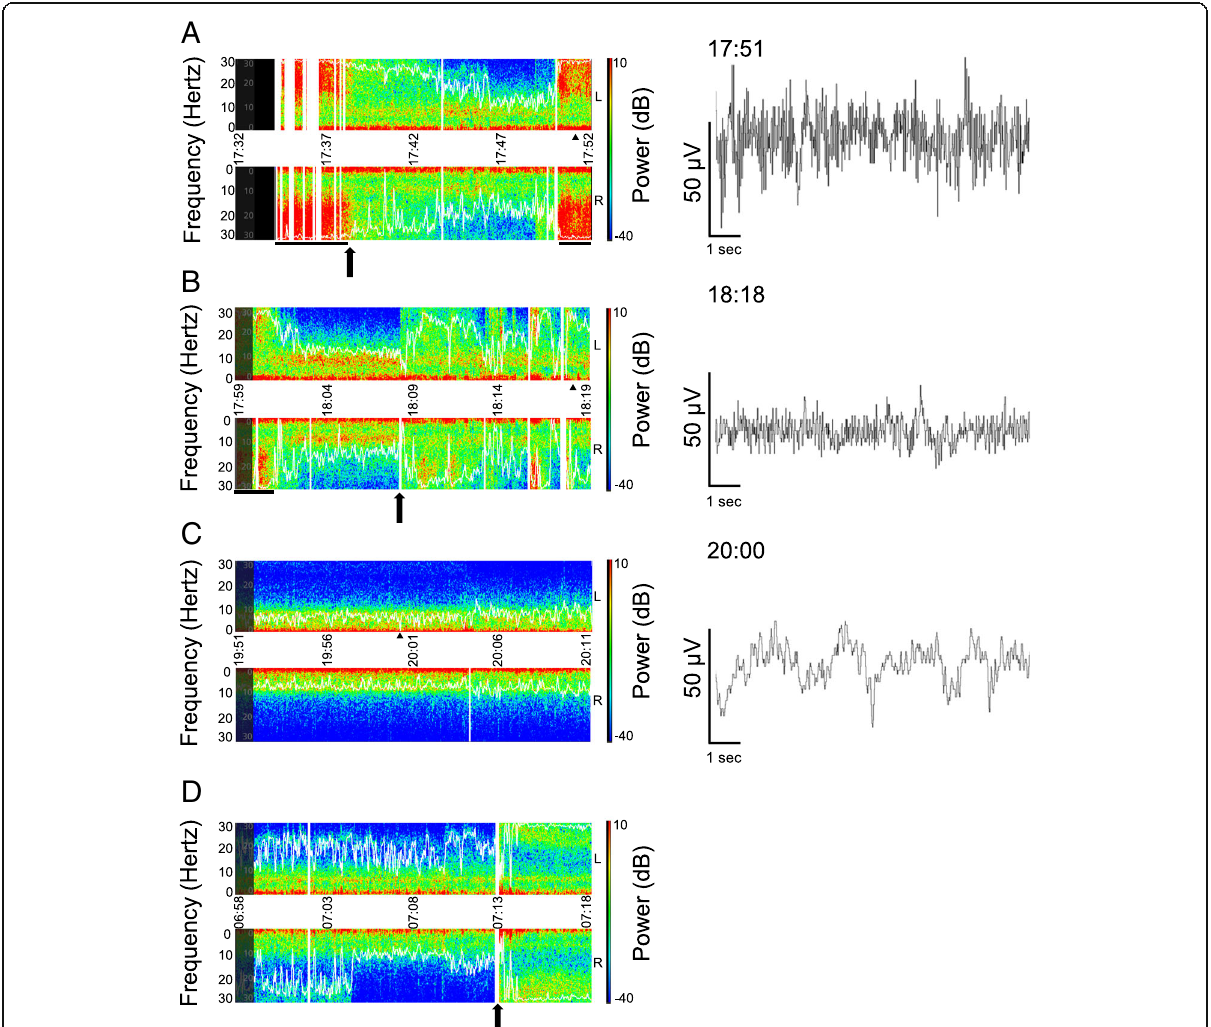
Fig. 1 Screen captures of color density spectral array (CDSA) in the intensive care unit. The upper and lower portions of left panels represent EEG power spectrum obtained from the left and right forehead, respectively. X -axis represents time. Y -axes represent frequency (Hz). The farther from the center horizontal line the higher the frequency. The right vertical line represents power of EEG (dB) where warmer colors represent higher power. White curves represent spectral edge frequency 95%, which is the frequency below which 95% of the spectral power of an EEG resides. Vertical white bars represent missing data on CDSA due to artifacts. Right panels represent 10-s EEG in the left front polar (fp1) region, corresponding to selected time points (black triangle) in left panels. a CDSA immediately after the patient entered the ICU. A black arrow represents the time of administration of diazepam 5mg iv. Black horizontal bars represent convulsions. b A black arrow represents the start of dexmedetomidine administration. c Approximately 2h after the start of dexmedetomidine infusion. Patient state index was about 23. d CDSA next morning. A black arrow represents the spontaneous awakening. PSI increased from 40 to 83 in a minute. Corresponding EEG of d could not be downloaded due to a technical failure. Although d shows an asymmetric CDSA, the cause is unknown. Raw EEG waves were illustrated by EDFbrowser 1.64 (https://www.teuniz.net/edfbrowser/; last accessed on February